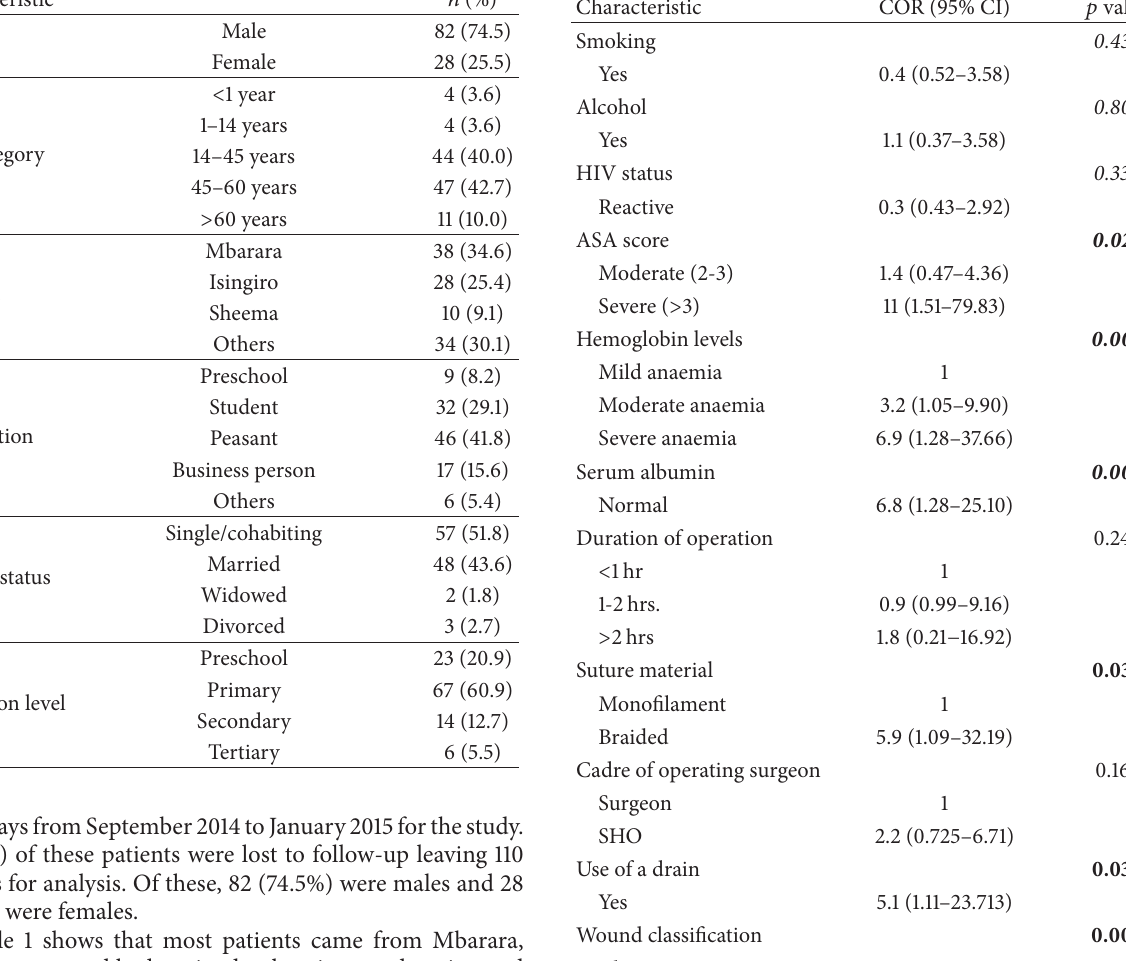
Table 1: Demographic characteristics of study population. Characteristic